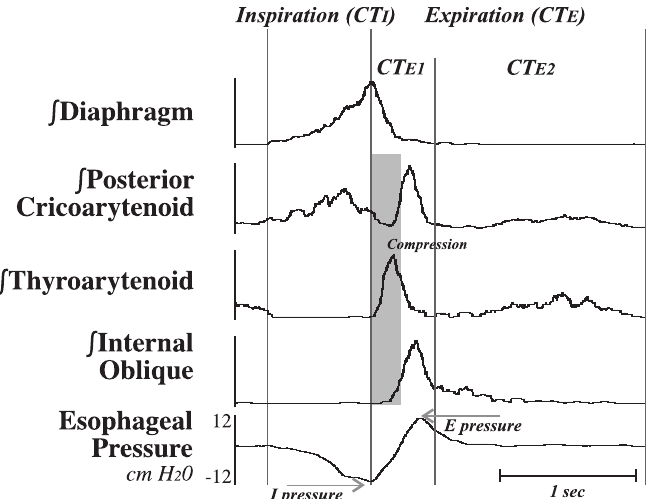
Fig 1. Representative example with integrated EMG traces used to define the phases of a single cough. The inspiratory phase of cough (CT I ) was defined as the period of time between the start of diaphragm activity to the peak of the integrated diaphragm EMG, while the expiratory period (CT E ) consisted of the time between the peak of the diaphragm to the subsequent start of activity on the diaphragm. CT E was subdivided into an active expiratory phase (CT E1 ) beginning at the end of CT I and continuing to the end of the ballistic effort on the internal oblique EMG, and a passive expiratory phase (CT E2 ) beginning at the end of CT E1 and the start of the next CT I . The theoretical compression phase of cough is highlighted in grey (all animals had a tracheostomy), corresponding to the ballistic activity of the